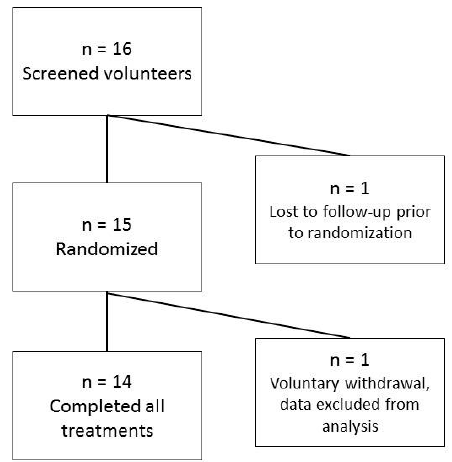
Figure 1. Subject flow through study.